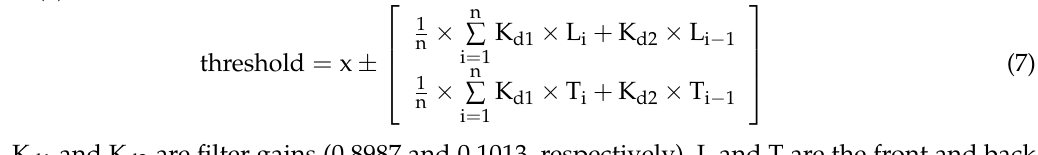
Table 2. Ultrasonic tethering system modes of operation.